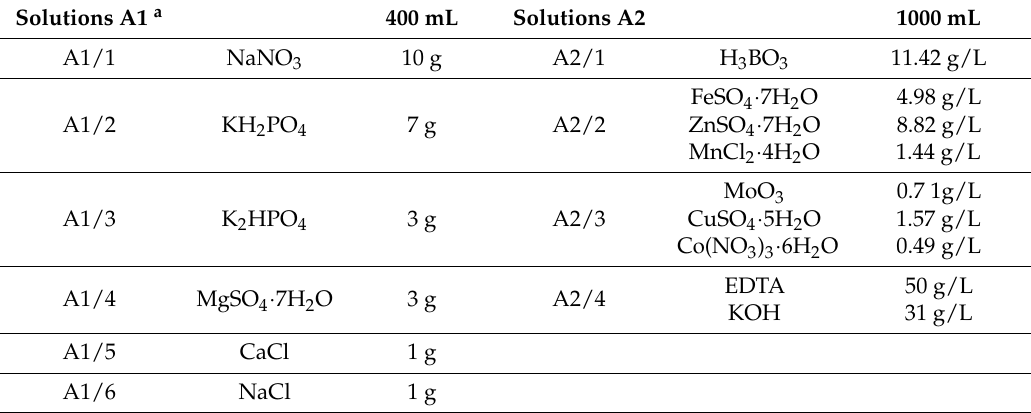
Table A5. Bold’s Basal medium (BBM, Nichols and Bold, 1965) as part of the TM components.